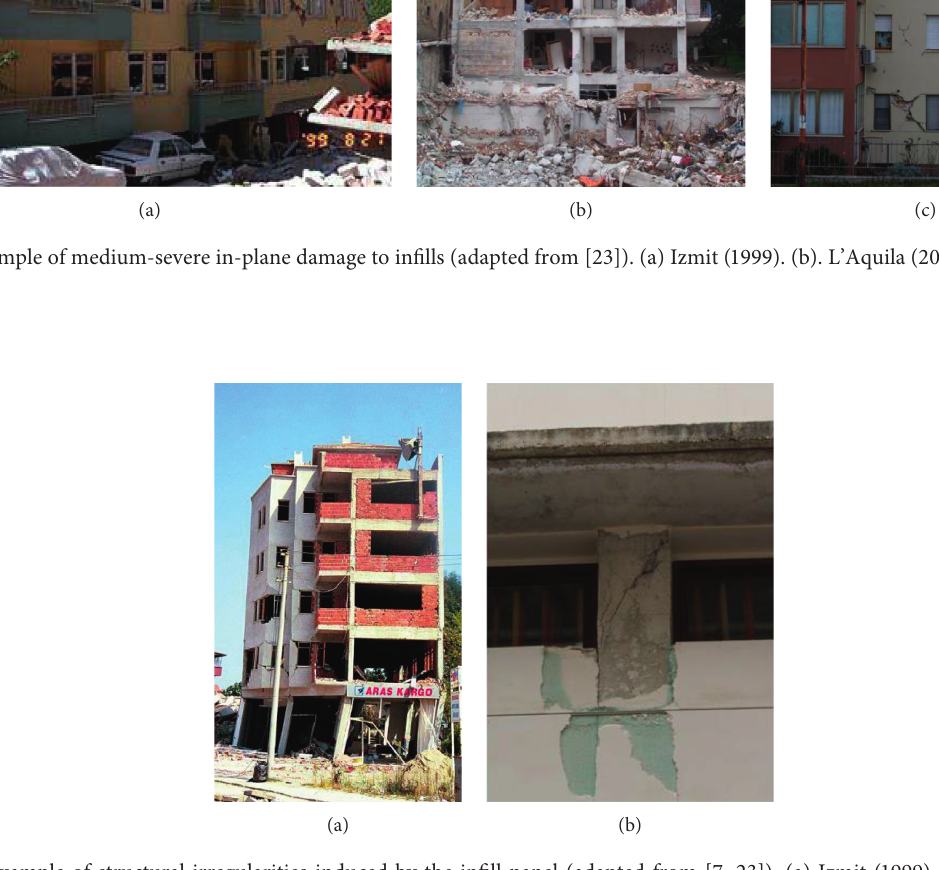
Figure 2: Example of structural irregularities induced by the infill panel (adapted from [7, 23]). (a) Izmit (1999). (b) Lorca (2011).